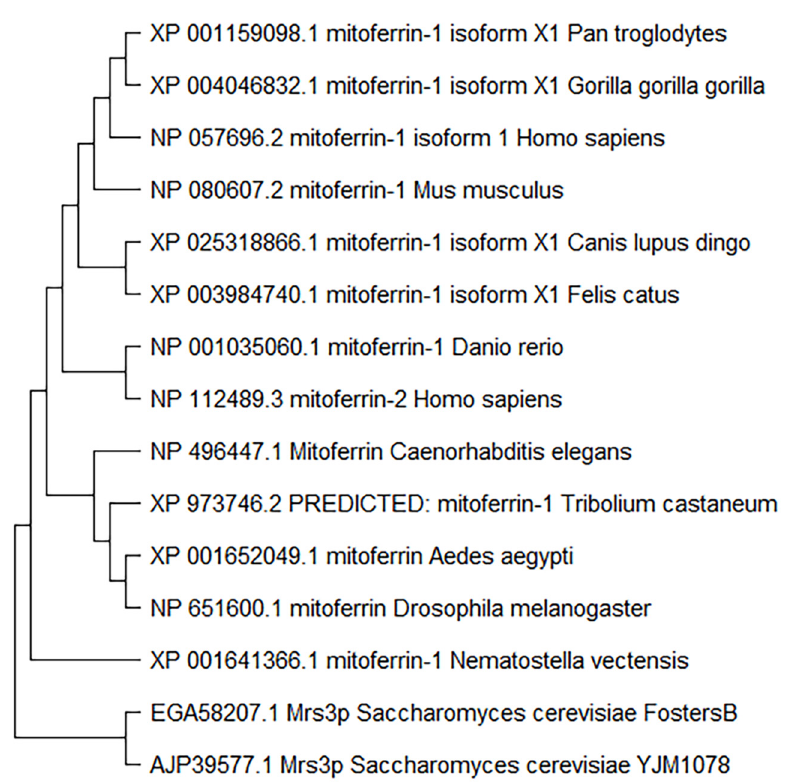
Figure 3. Maximum likelihood phylogenetic tree of mitoferrin-1 protein sequences. The length of the branches indicates evolutionary time. The protein sequences were selected by BLASTP and aligned using MUSCLE alignment. The maximum likelihood phylogenetic tree was then constructed using MEGAX (v11).